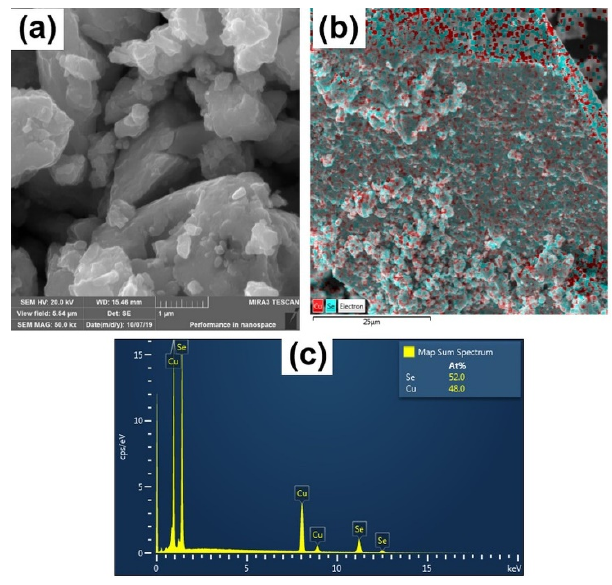
Figure 4. SEM analysis of CuSe-PM: ( a ) image; ( b ) elemental mapping; ( c ) EDX spectrum.